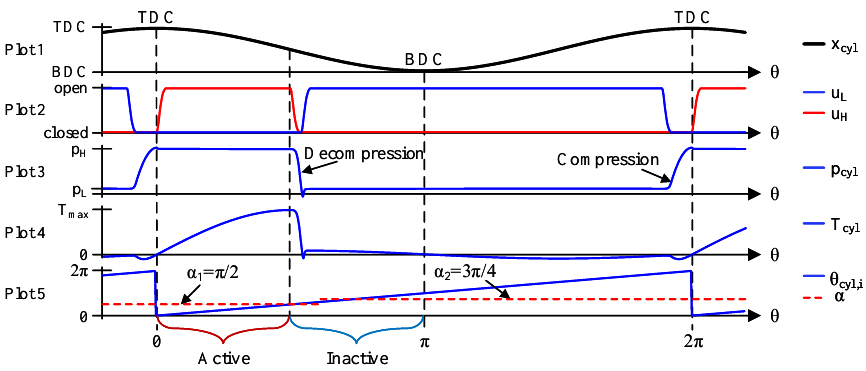
Figure 4. Valve timing schematics for partial stroke displacement strategy Version